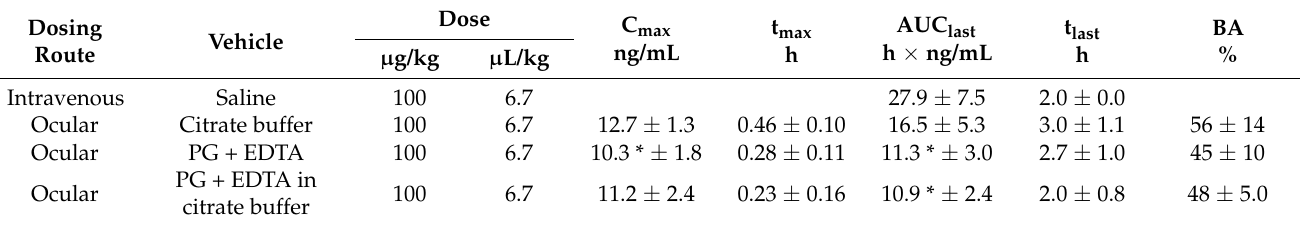
Figure 2. Naloxone plasma concentrations after intravenous administration and after ocular administration using three different formulations. Upper panel: naloxone plasma concentrations during the first 4 h after administration; lower panel: during the first hour after administration. Mean + standard deviation are shown. Six dogs received naloxone intravenously and six dogs received each of the eye drop formulations. EDTA, ethylenediaminetetraacetic acid; i.v., intravenous; PG, propylene glycol. Table 2. Pharmacokinetic parameters of naloxone after ocular administration in three vehicles.